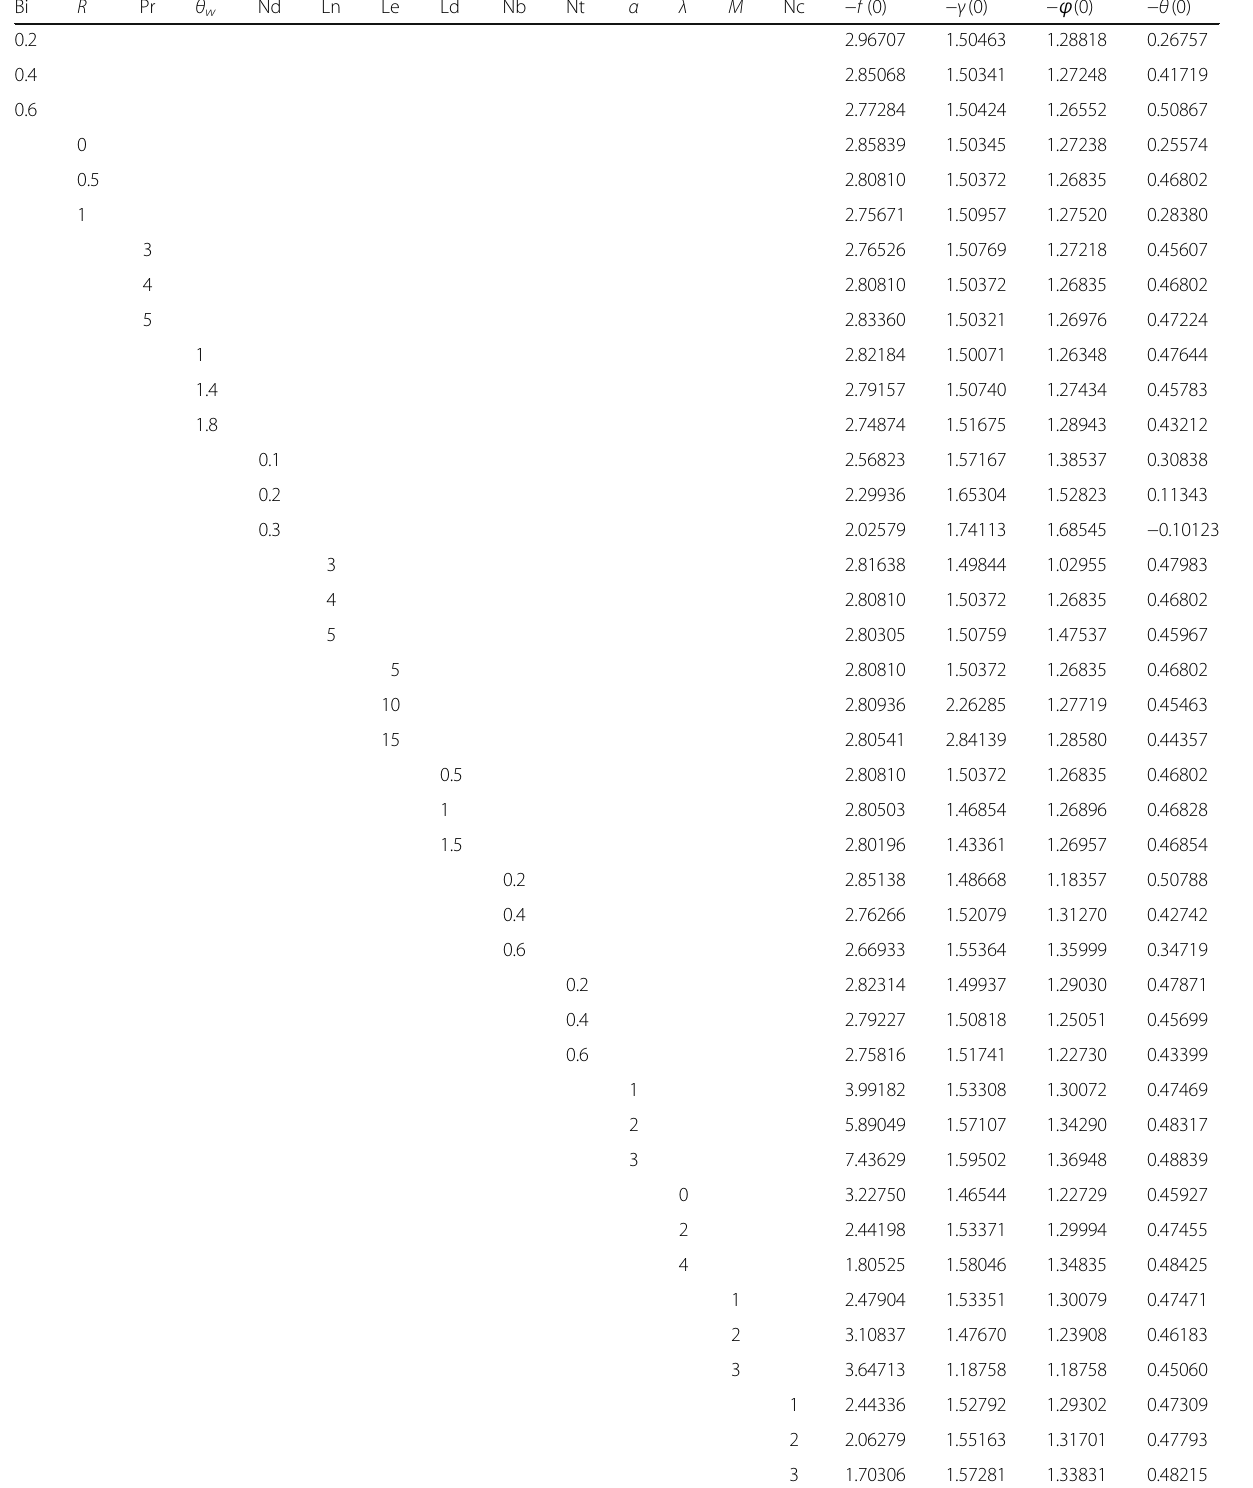
Table 5 Numerical values of − f ′′ (0) , − γ ′ (0) , − θ ′ (0) and − ϕ ′ (0) for different physical